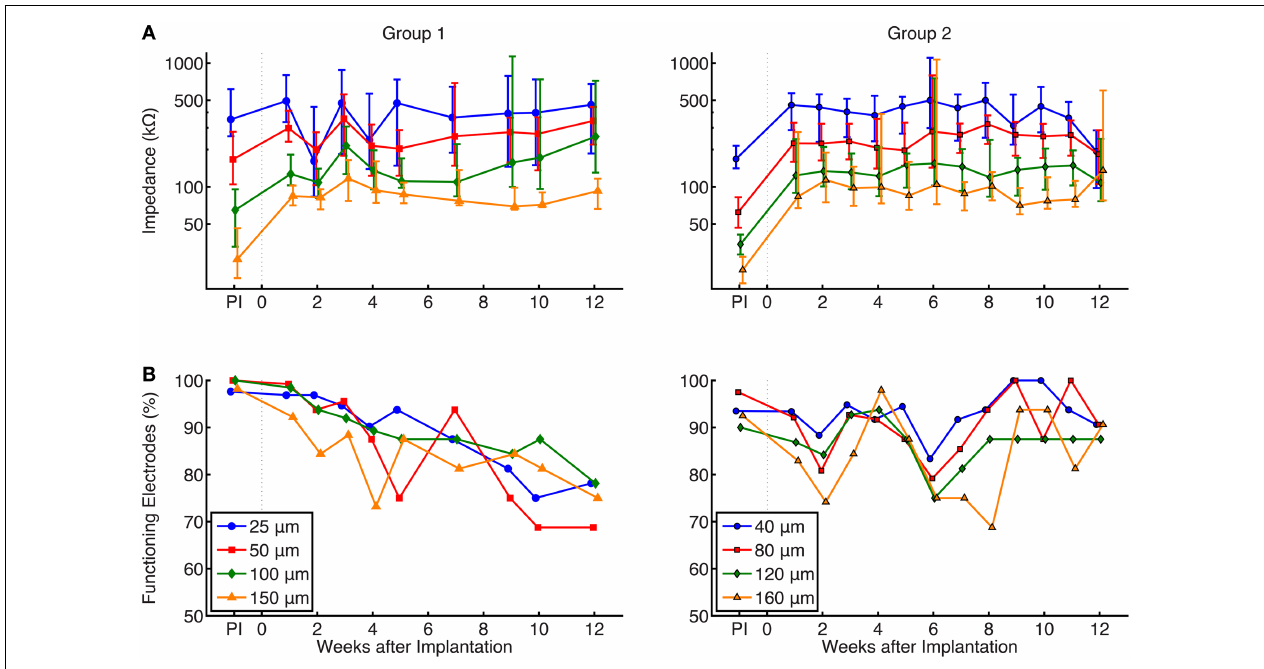
range of 50–500k Ω while implanted. Results of a Kruskal–Wallis test showed that site size was statistically significant ( p < 0.01) in both groups, while the effect of time was not significant ( p = 0.86 and 0.35 for groups 1 and 2, respectively.) (B) Percentage of implanted electrodes with impedances <2M Ω and >10k Ω . Each time point represents all implanted electrodes at each week, while electrodes from FMAs that suffered catastrophic failures were not included. Around 70–80% of group 1 and 90% of group 2 electrodes that remained implanted were functional at